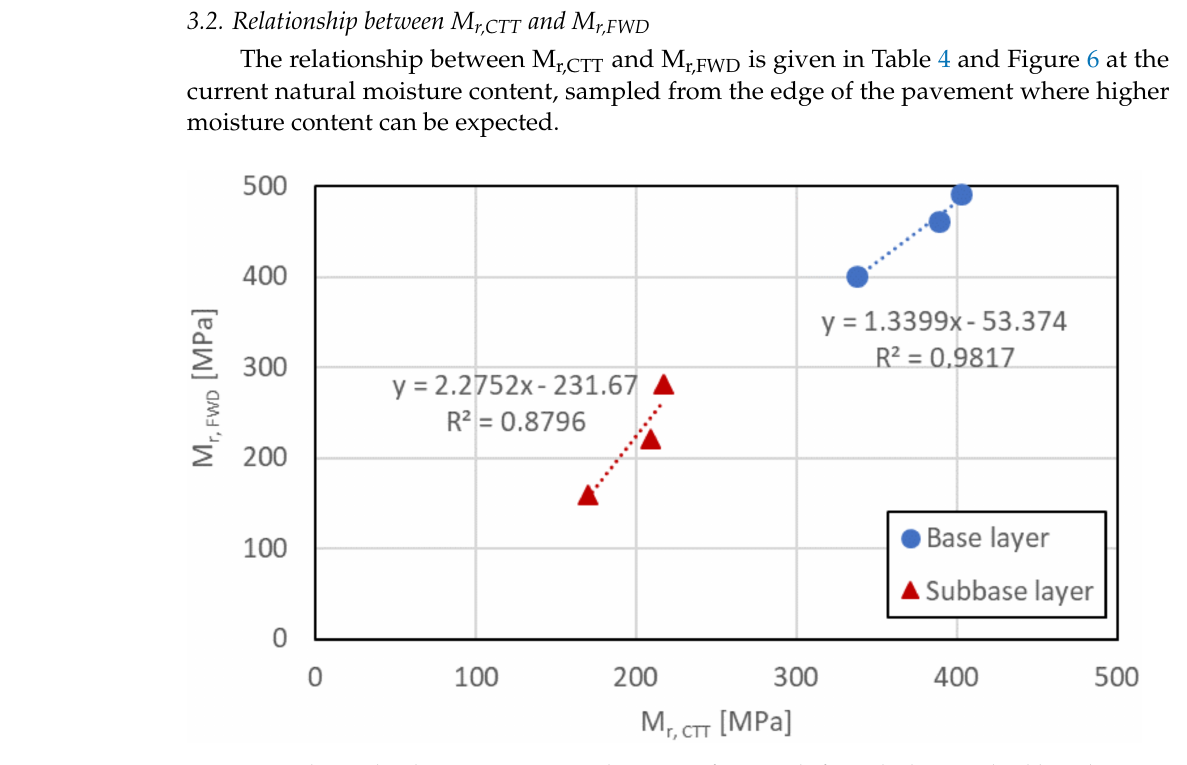
Figure 6. Relationship between M r,CTT and M r,FWD of materials from the base and subbase